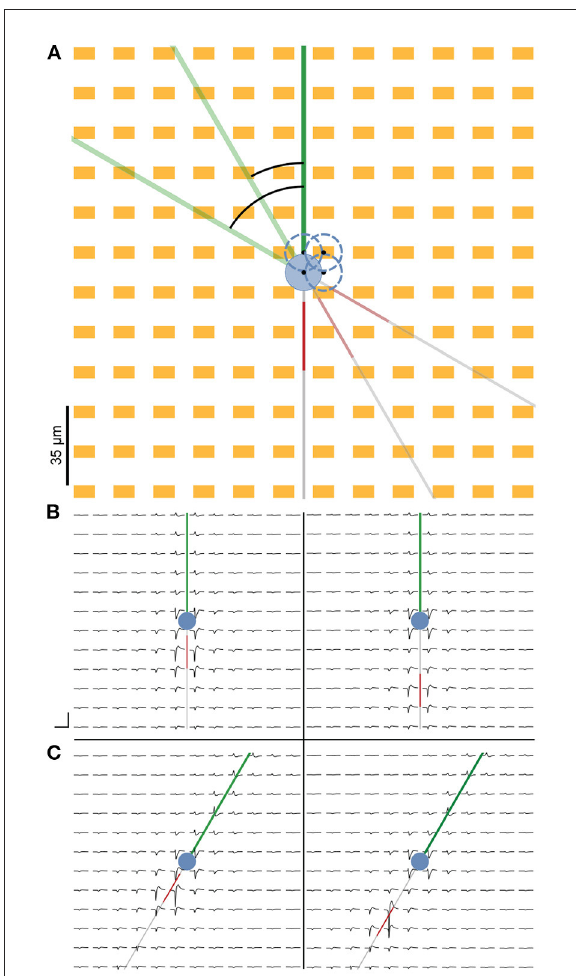
FIGURE2 Representation of the cell on the simulated HD-MEA. (A) We simulated the neuron at four different somatic positions to account for extracellular footprint variability due to slight differences in the positions of the neural compartments relative to the electrodes. Neuron positions are indicated by the blue dashed circles, and the black dots represent the center of the soma. Additionally, the entire neuron was rotated 360 ◦ at 1 ◦ increments for each cell position to simulate the extracellular footprints pertaining to various possible neuronal orientations. (B) Simulated extracellular footprint of a cell with the baseline AIS starting 5 µ m from the soma (left) and the farthest simulated AIS position being at 40 µ m distance from the soma (right). (C) Extracellular footprint with the same soma position as in (B) , but with the neuron rotated clockwise by 30 ◦ relative to the baseline. Scale bar: 3 ms (horizontal) and 100 µ V